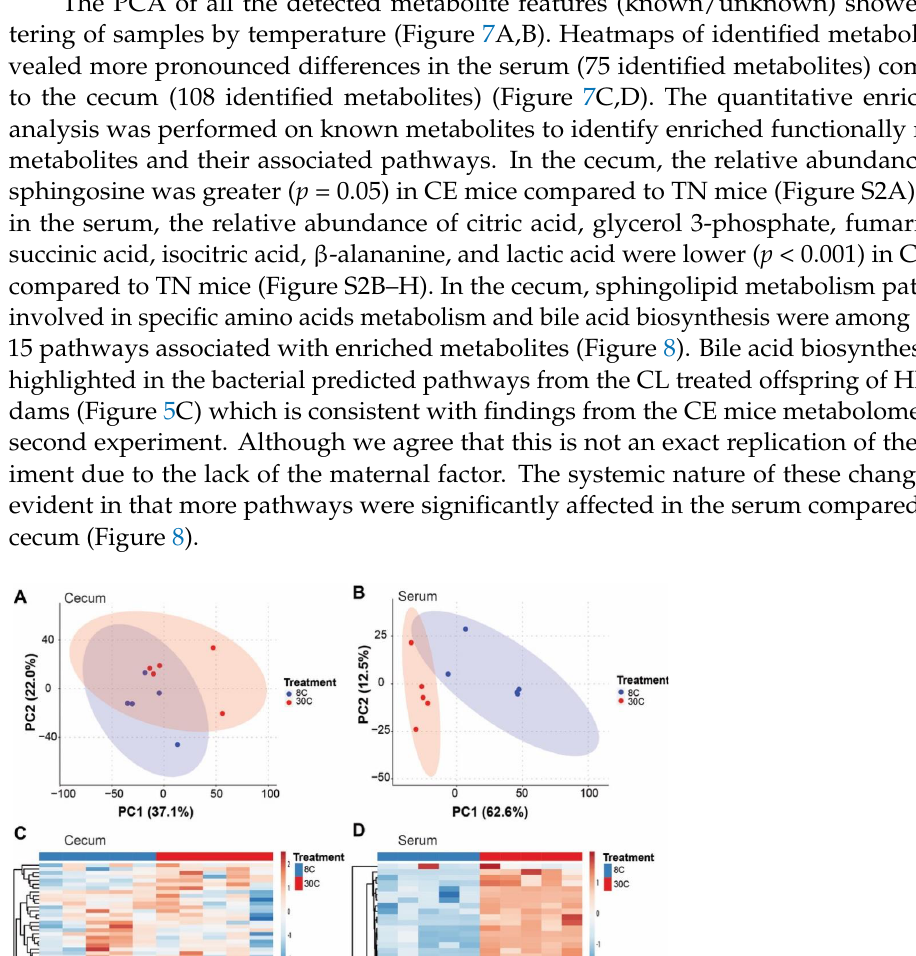
Figure 8. Metabolic pathways (top 15) in the ( A ) cecum and ( B ) serum associated with enriched metabolites in mice exposed to cold (8 °C) or thermoneutral (30 °C) temperatures. Quantitative en- richment analysis was performed on identified metabolites in the cecum (n = 108) and serum (n = 75) using MetaboAnalyst v5.0.